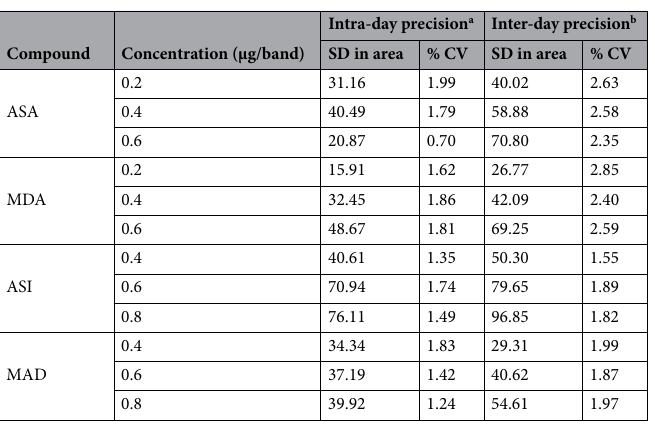
Table 4. Intra-day and inter-day precision of ASA, MDA, ASI and MAD. a Mean SD of four trials on same day. b Mean SD of two trials for consecutive 5 days; % CV: Coefficient of variation